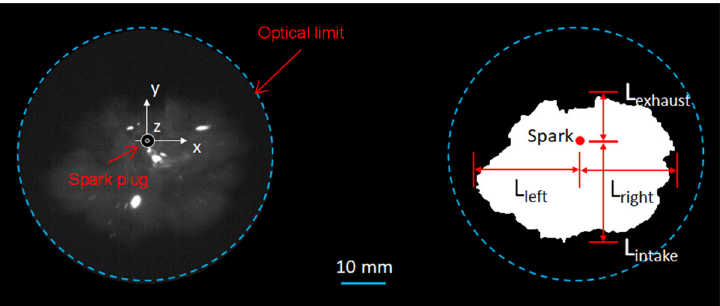
Figure 3 . Raw and binary image for flame propagation